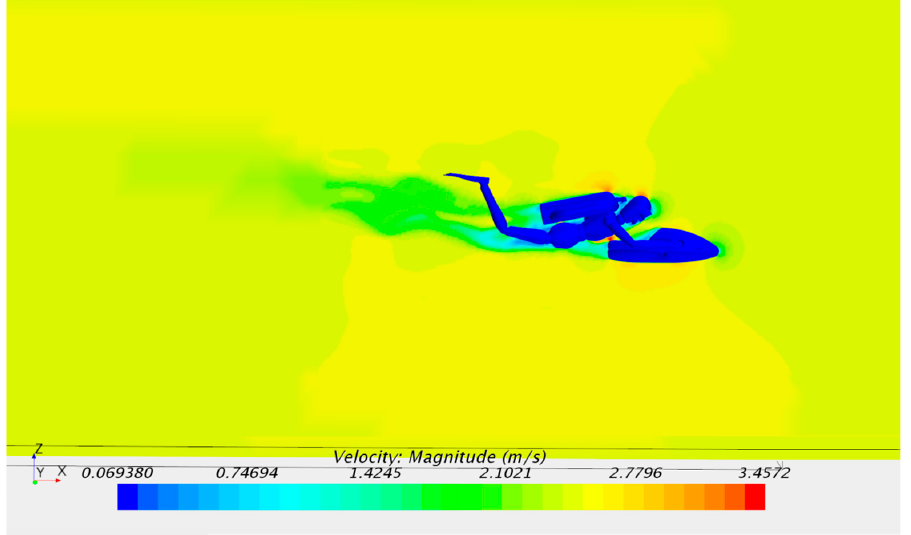
Figure 16. Velocity nephogram at 2s moment of straight-line cruising with releasing motion at V 5 speed.